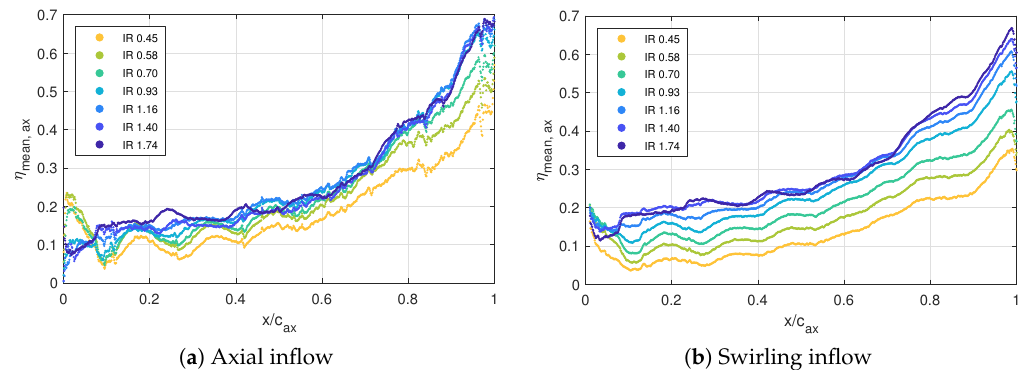
Figure 10. Laterally averaged film cooling effectiveness η for different injection ratios IR along the normalized axial chord x / c ax